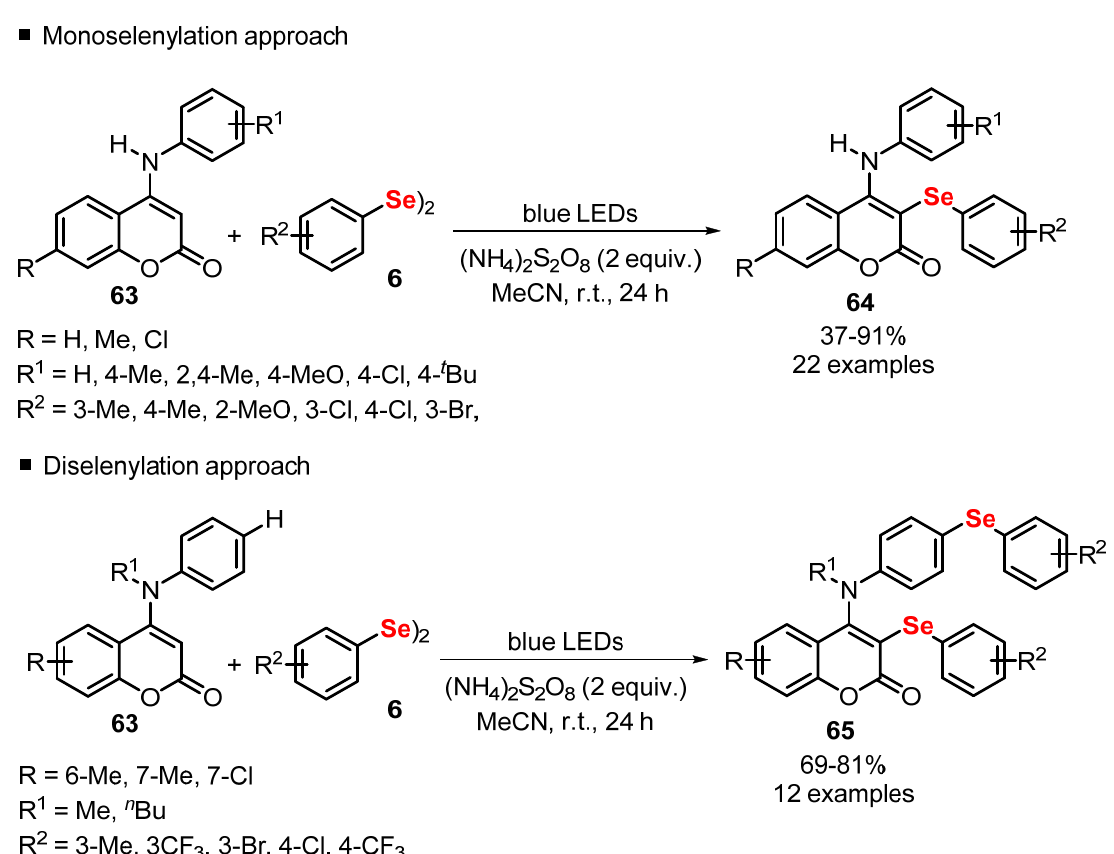
Scheme 28. Rose Bengal ‐ catalyzed synthesis of 3 ‐ selenylindoles 2 .